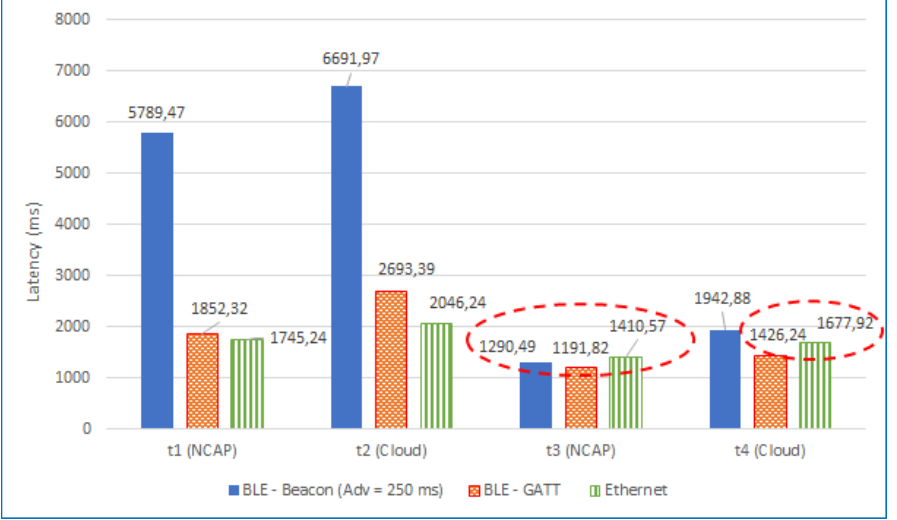
Figure 36. Total latencies for the Line-of-Sight (LoS)